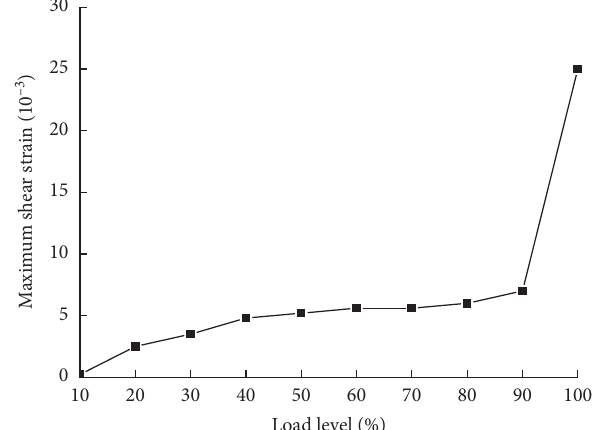
Figure 8: Evolution of maximum shear strain (B-5).